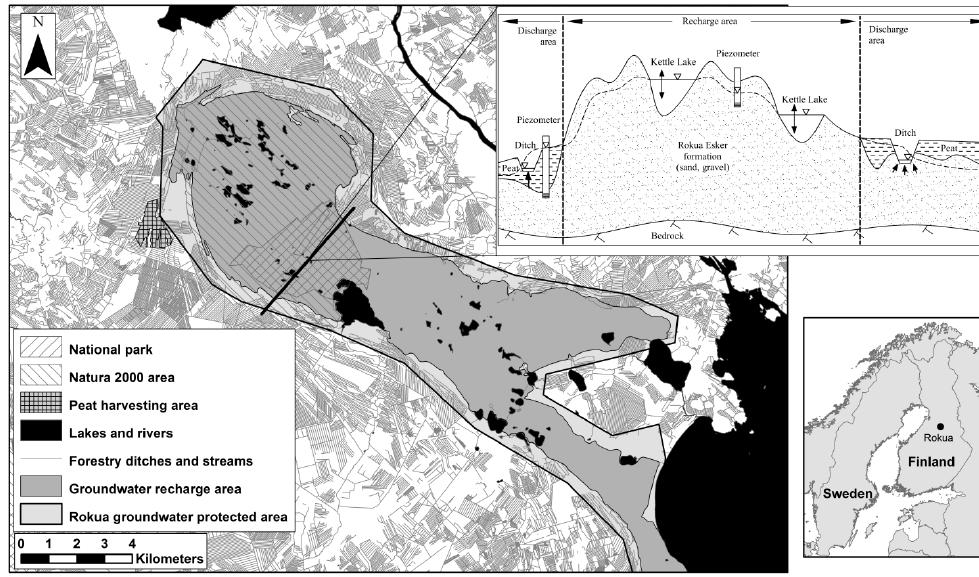
Figure 1. The Rokua esker area and a cross-section sketch of the esker with recharge and discharge